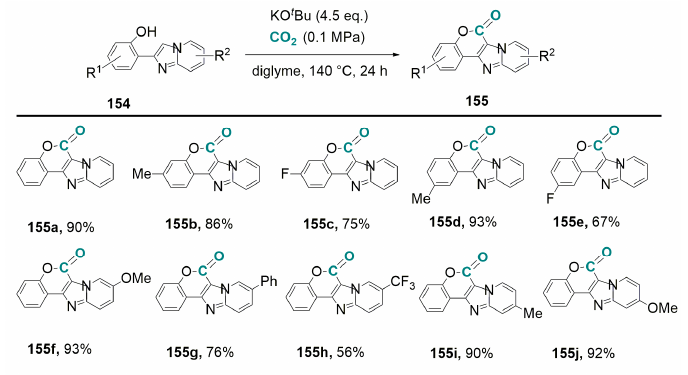
Scheme 65. Selected examples for carboxylation reactions of 2-(imidazo[1,2- a ]pyridine-2-yl)phenol derivatives followed by lactonization.